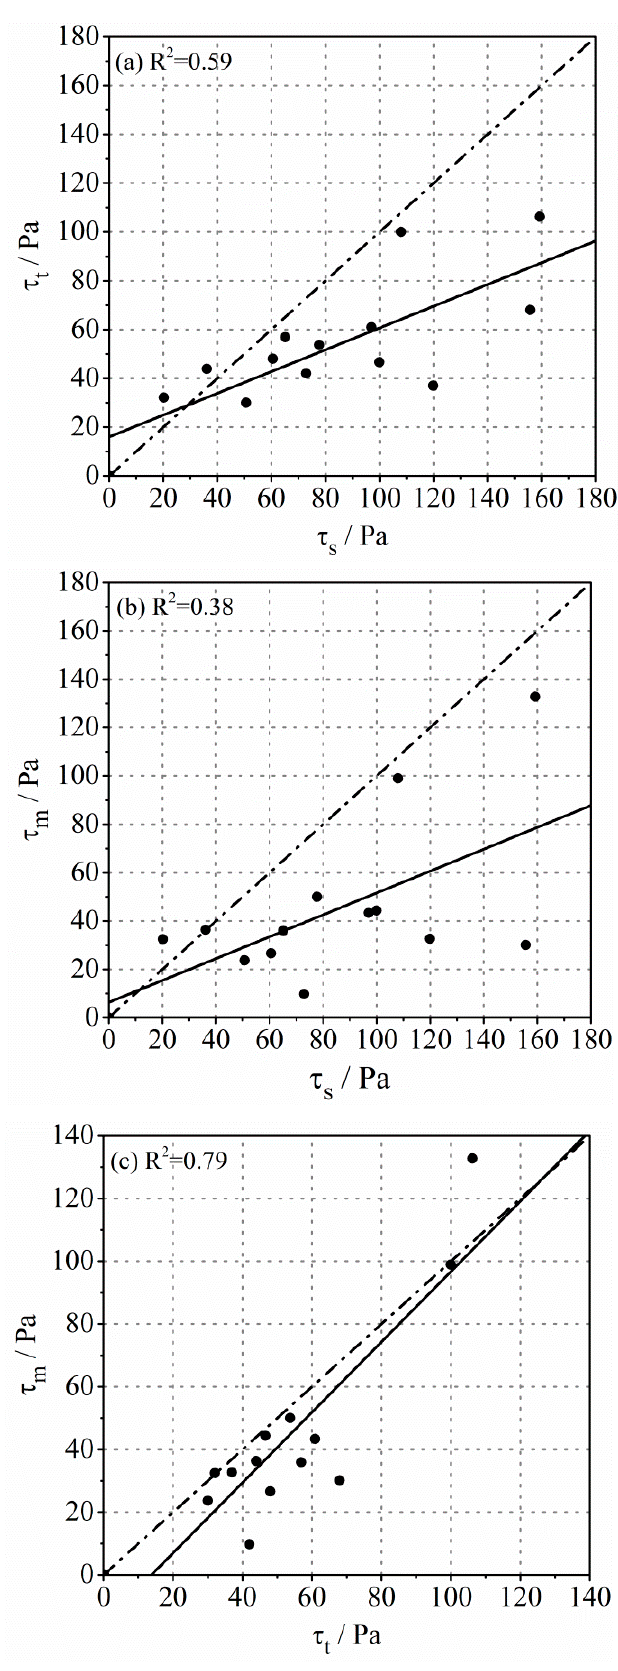
Figure 5. Comparison of the yield stress of the lubrication layer determined by different methods: